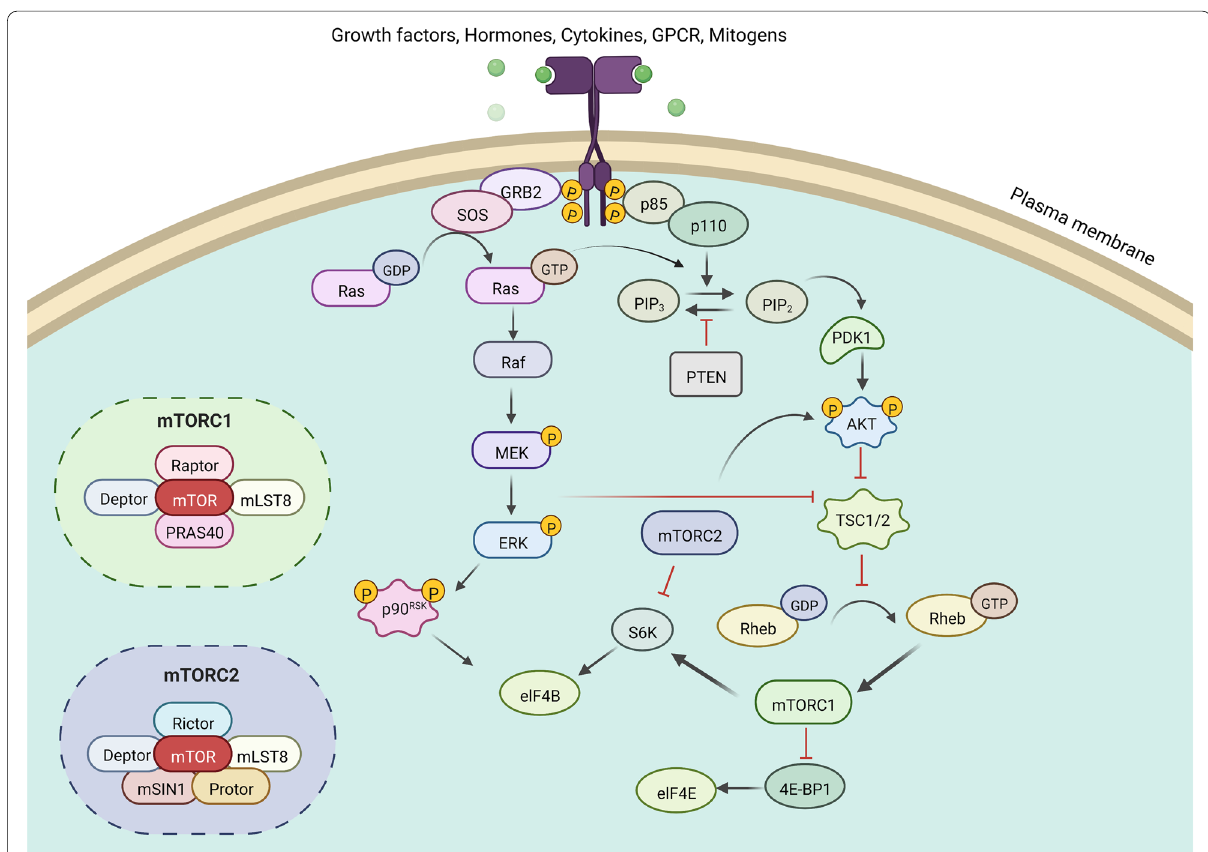
Fig. 1 Schematic of the PI3K/AKT/mTOR and Raf/MEK/ERK signaling pathways. Growth factors, hormones, cytokines, GPCRs, and mitogens activate receptor tyrosine kinases (RTKs) recruiting PI3K to attach to the plasma membrane, where PI3K catalyzes PI (4,5) P2 to PI (3,4,5) P3. PTEN suppressed the process, and PTEN mutations could induce abnormal activation. PI (3,4,5) P3 promotes AKT activation via the activity of PDK1 and mTORC2. AKT activation induced cell cycle progression, cell growth, cell apoptosis, survival, glucose metabolism, protein synthesis, signal triggering and transduction, and phosphorylation of the downstream substrate TSC2. AKT activation suppressed the activity of TSC2 to promote the production of Rheb complex, resulting in mTORC1 activation. mTORC1 activation facilitates the initiation of eukaryotic protein translation. 4E-binding protein 1 (4E-BP1) activation enhanced the release of eukaryotic translation initiation factor 4E (eIF4E). RTK activation further accelerates guanine exchange factor to load RAS with GTP. RAS–GTP dimers recruit RAFs or RAF/MEK heterodimers to membranes, where tetramers consisting of RAF and MEK promote RAF activation. MEK activation is initiated by docking on RAF dimers, which further facilitate ERK phosphorylation. RTKs, receptor tyrosine kinase; PI3K, phosphatidylinositol 3-kinase; PIP2, phosphatidylinositol 4,5-bisphosphate; PIP3, phosphatidylinositol 3,4,5-triphosphate; PTEN, phosphatase and tensin homolog; PDK1,3-pphosphoinositide-dependent kinase 1; mTOR, mechanistic target of rapamycin; TSC1, tuberous sclerosis 1; TSC2, tuberous sclerosis 2; 4E-BP, eIF4E-binding protein; GRB10, growth factor receptor-bound protein 10; IGF-1R, insulin-like growth factor 1 receptor; mLST8, mammalian lethal with SEC thirteen 8; RICTOR, rapamycin-insensitive companion of mTOR; S6K, ribosomal S6 kinase; FLCN, folliculin; ULK1, UNC-51-like kinase 1; RAPTOR, regulatory-associated protein of mTOR; RICTOR, rapamycin-insensitive companion of